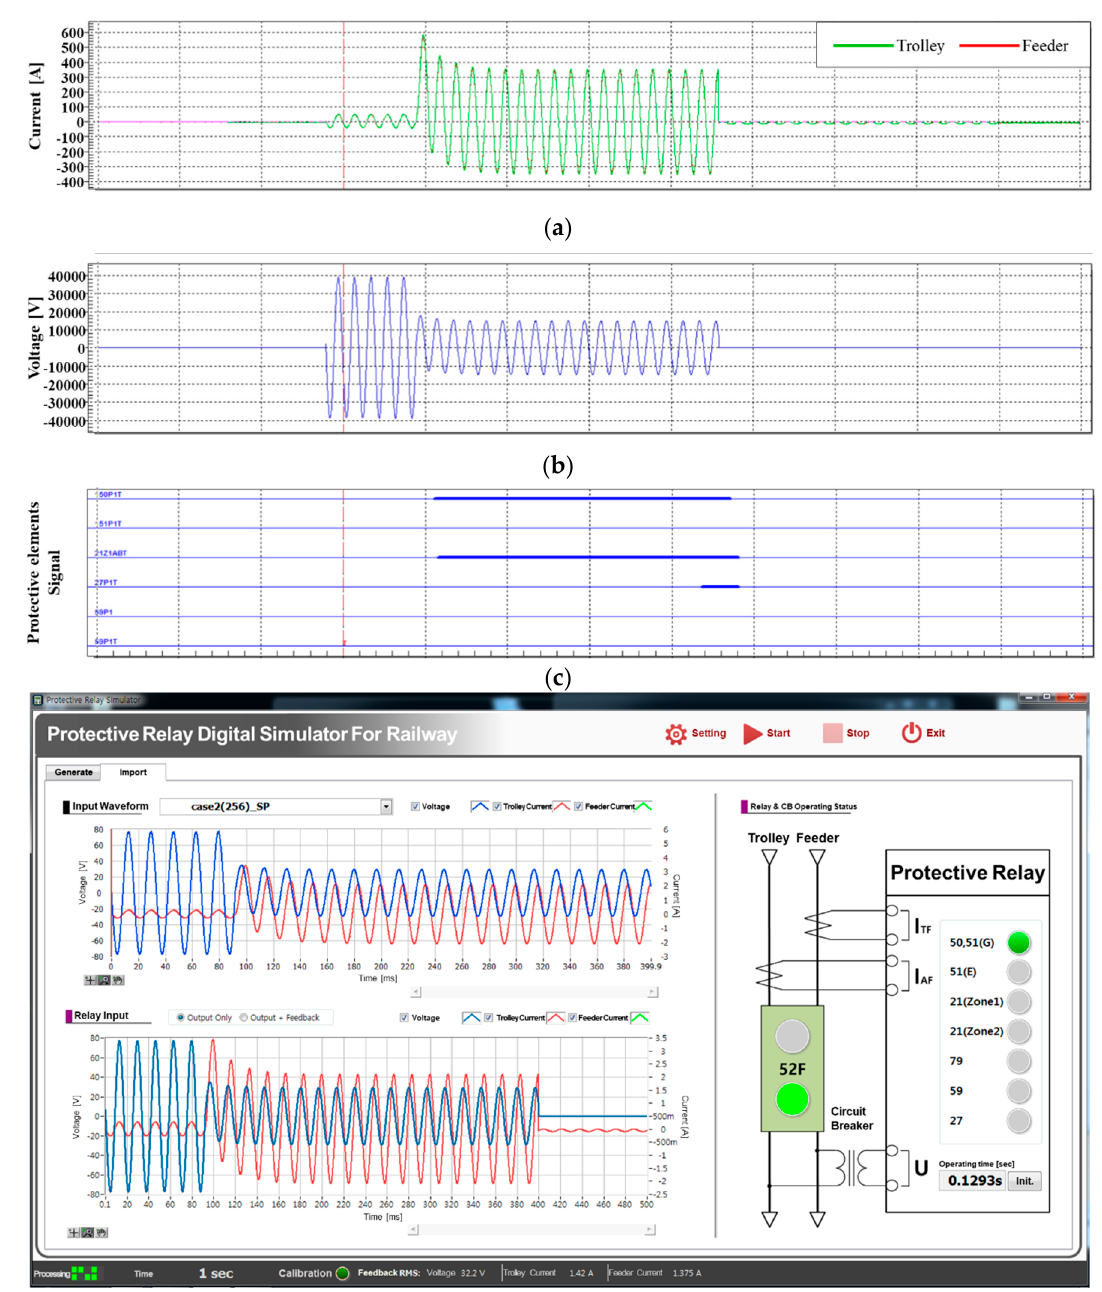
Figure 16. Simulation results for Case 2: ( a ) Input current; ( b ) Input voltage; ( c ) Protective relay signal; and ( d ) Digital simulator interface results.